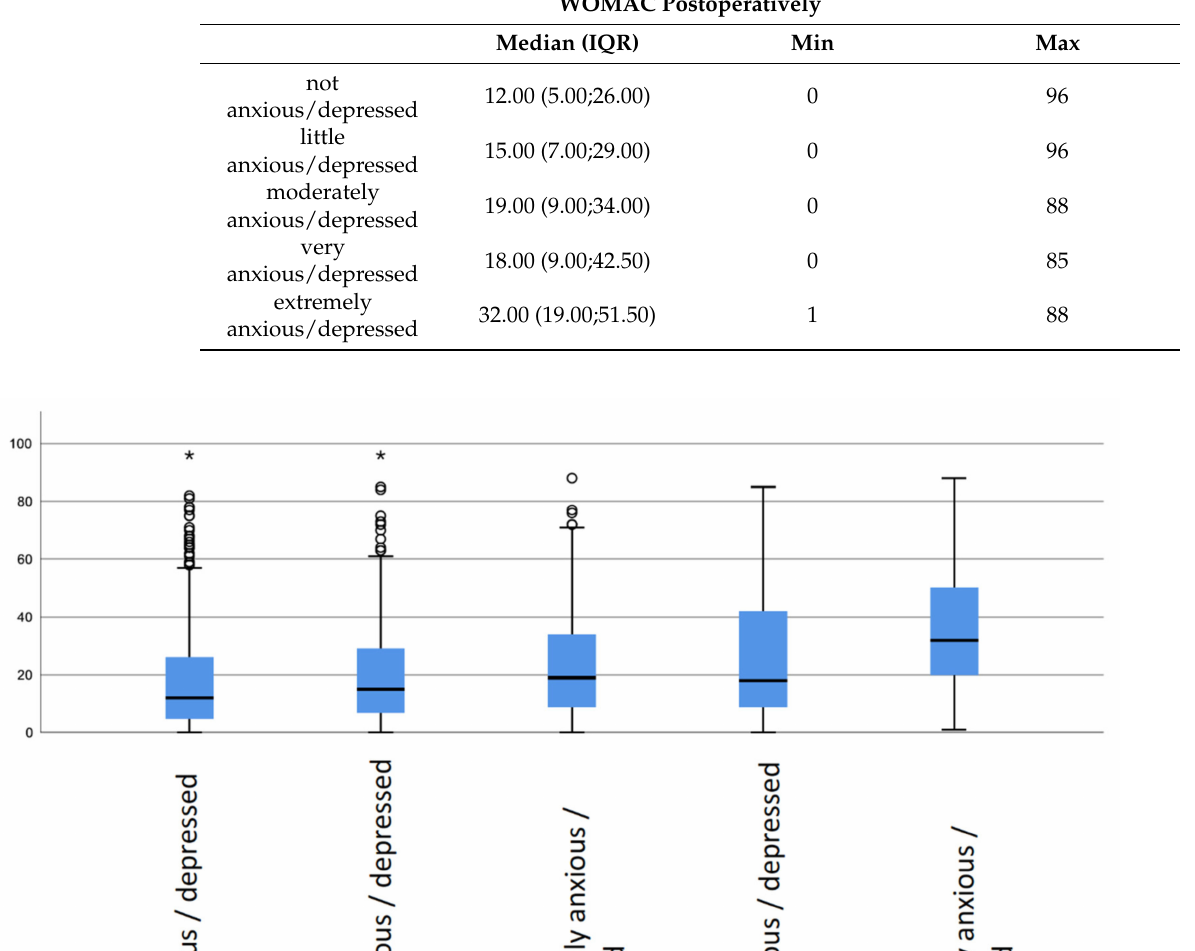
Table 4. The impact of preoperative anxiety/depression on Western Ontario and McMaster Uni- versities Osteoarthritis Index (WOMAC) postoperatively: Median (IQR), minimum and maximum values.